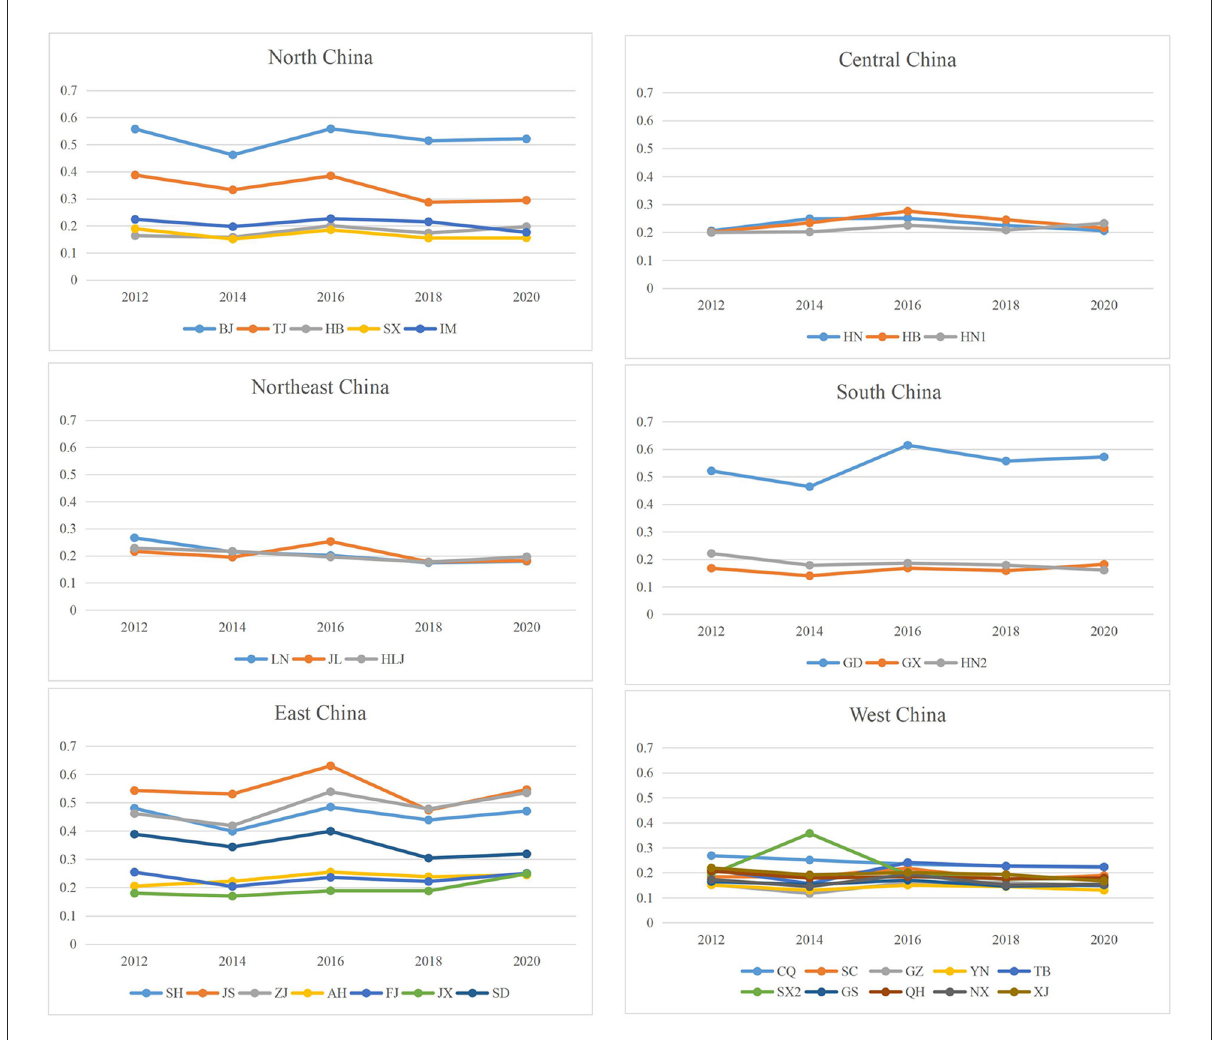
FIGURE1 Economic resilience trend map.